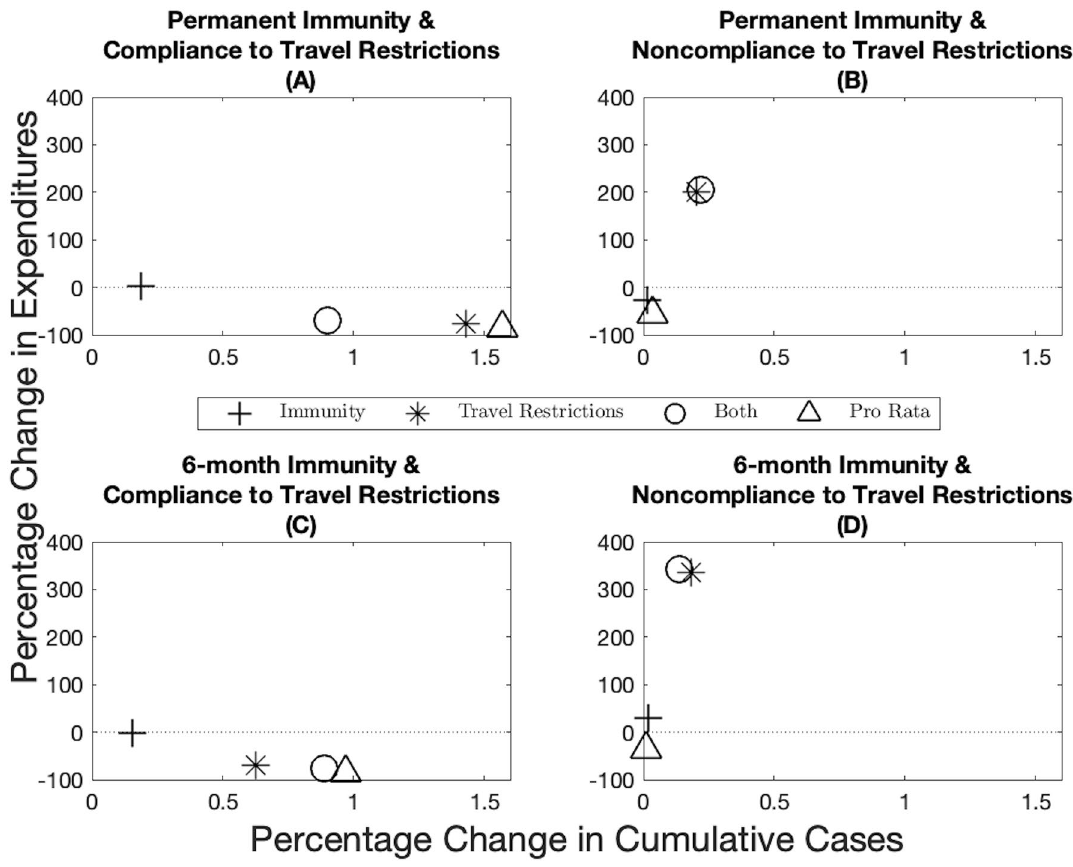
Figure 5. Robustness of epidemiological and economic outcomes under different scenarios when the source of heterogeneity is the contact rate. Percentage change in expenditures ( y -axis) and percentage change in cumulative cases ( x -axis) from the optimal allocation for different immunity-travel restrictions scenarios and for when vaccine capacity is